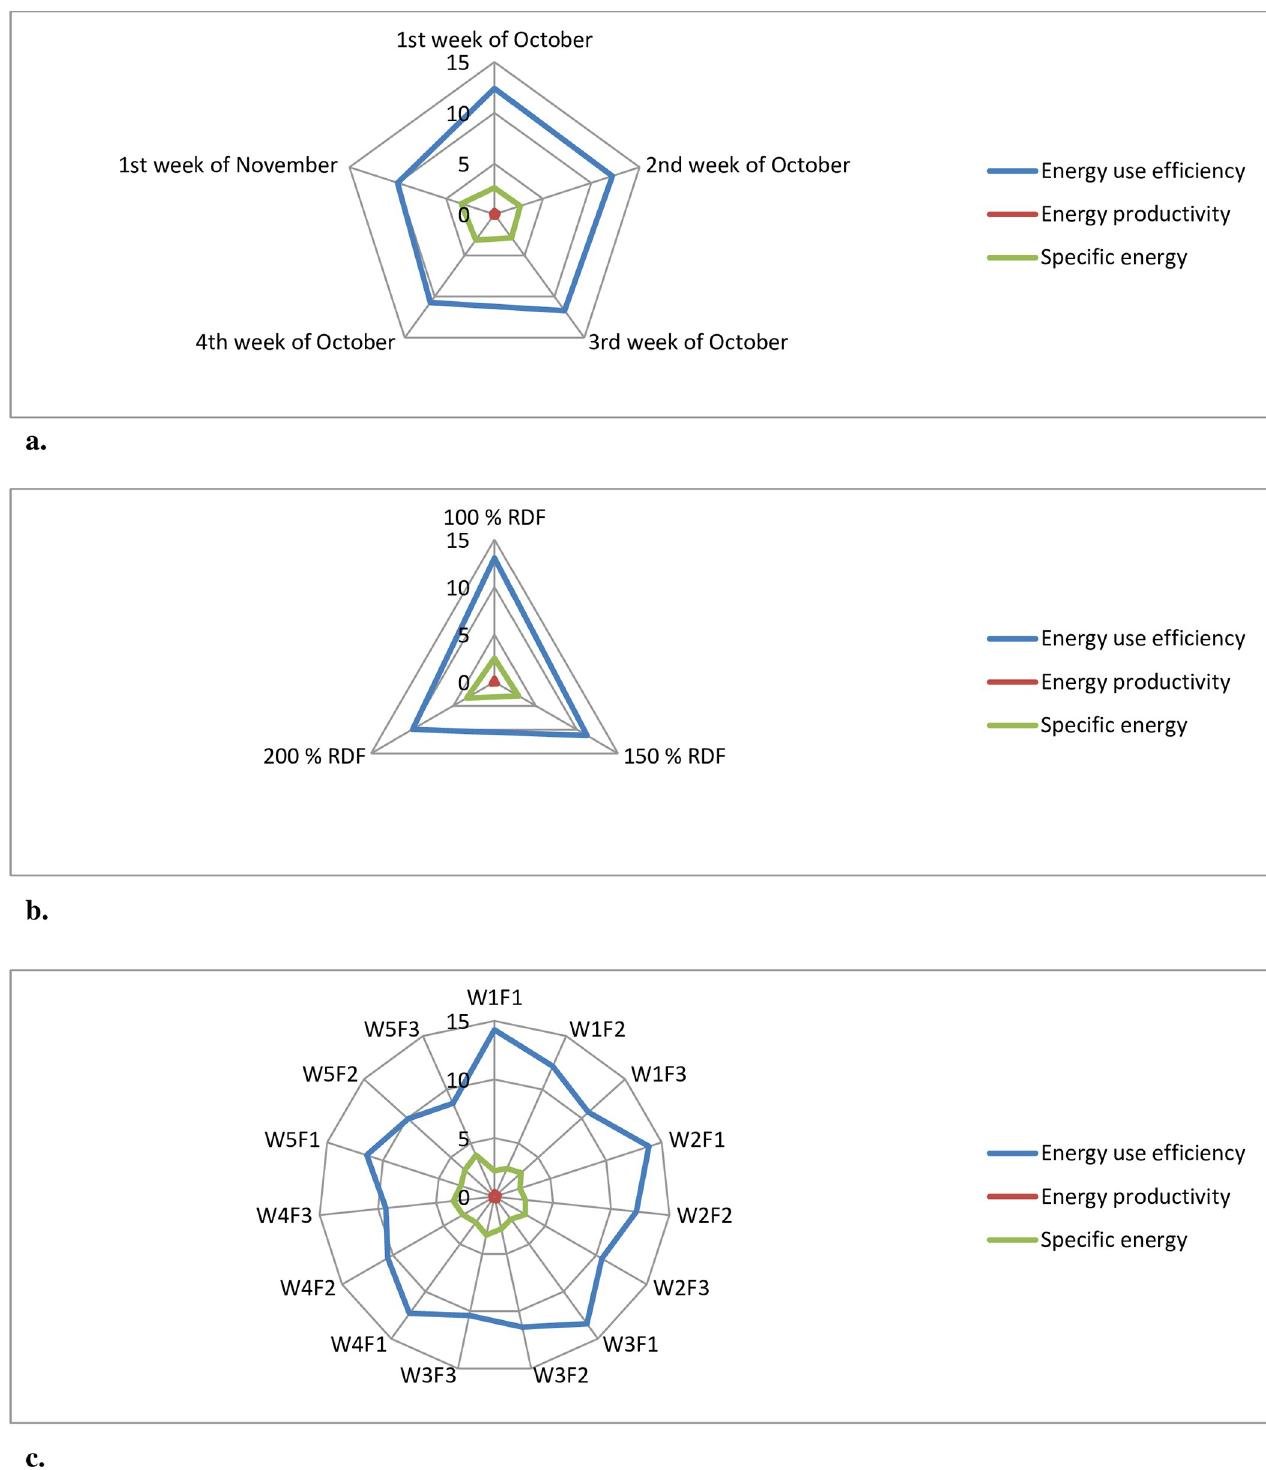
Fig 4. (a–c) represent radar chart representing multi-criteria assessment for energy use efficiency, energy productivity and specific energy for different sowing windows, fertility levels and their interactions respectively.